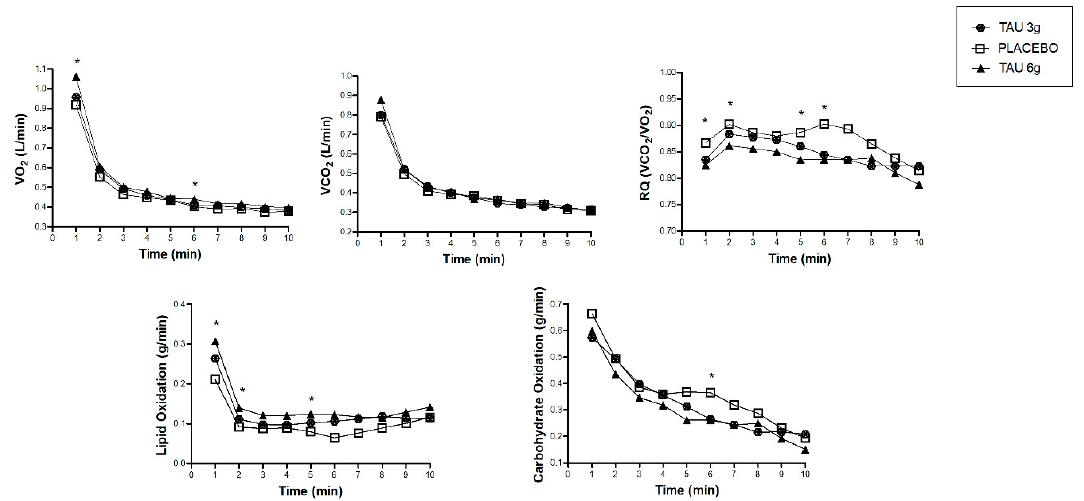
Figure 3. Time-course changes in the oxygen uptake (VO 2 ), carbon dioxide production (VCO 2 ), respiratory quotient (RQ), lipid oxidation, and carbohydrate oxidation of TAU 3 g, placebo, and TAU 6 g groups. * Difference between TAU 6 g and placebo groups in the time of measures. Statistical difference ( p < 0.05), by ANOVA two-way repeated measures (general linear model), post hoc Sidak for group*time interaction (respiratory quotient, lipid oxidation, and carbohydrate oxidation).